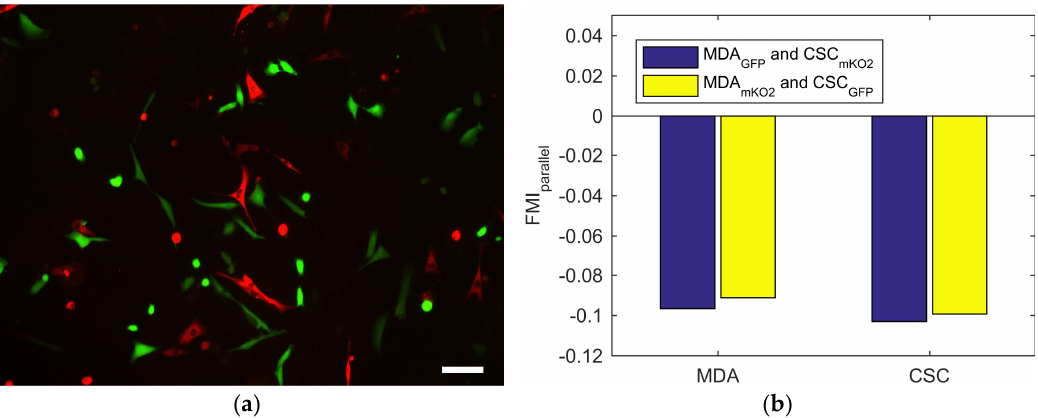
Figure 5. Fluorescent image and the average FMI for mixed populations of cancer stem cell (CSC) enriched and nonenriched MDA-MB-231 cells: ( a ) Representative fluorescent image of a mixed population of CSC enriched MDA-mKO2 cells, and MDA-GFP bulk cells. The scale bar is 100 μm. ( b ) The FMI parallel to the oxygen gradient for one experiment (blue) with MDA-GFP bulk cells and CSC enriched MDA-mKO2 cells (CSC mKO2 ), and another (yellow) with MDA-mKO2 bulk cells and CSC enriched MDA-GFP cells (CSC GFP ).